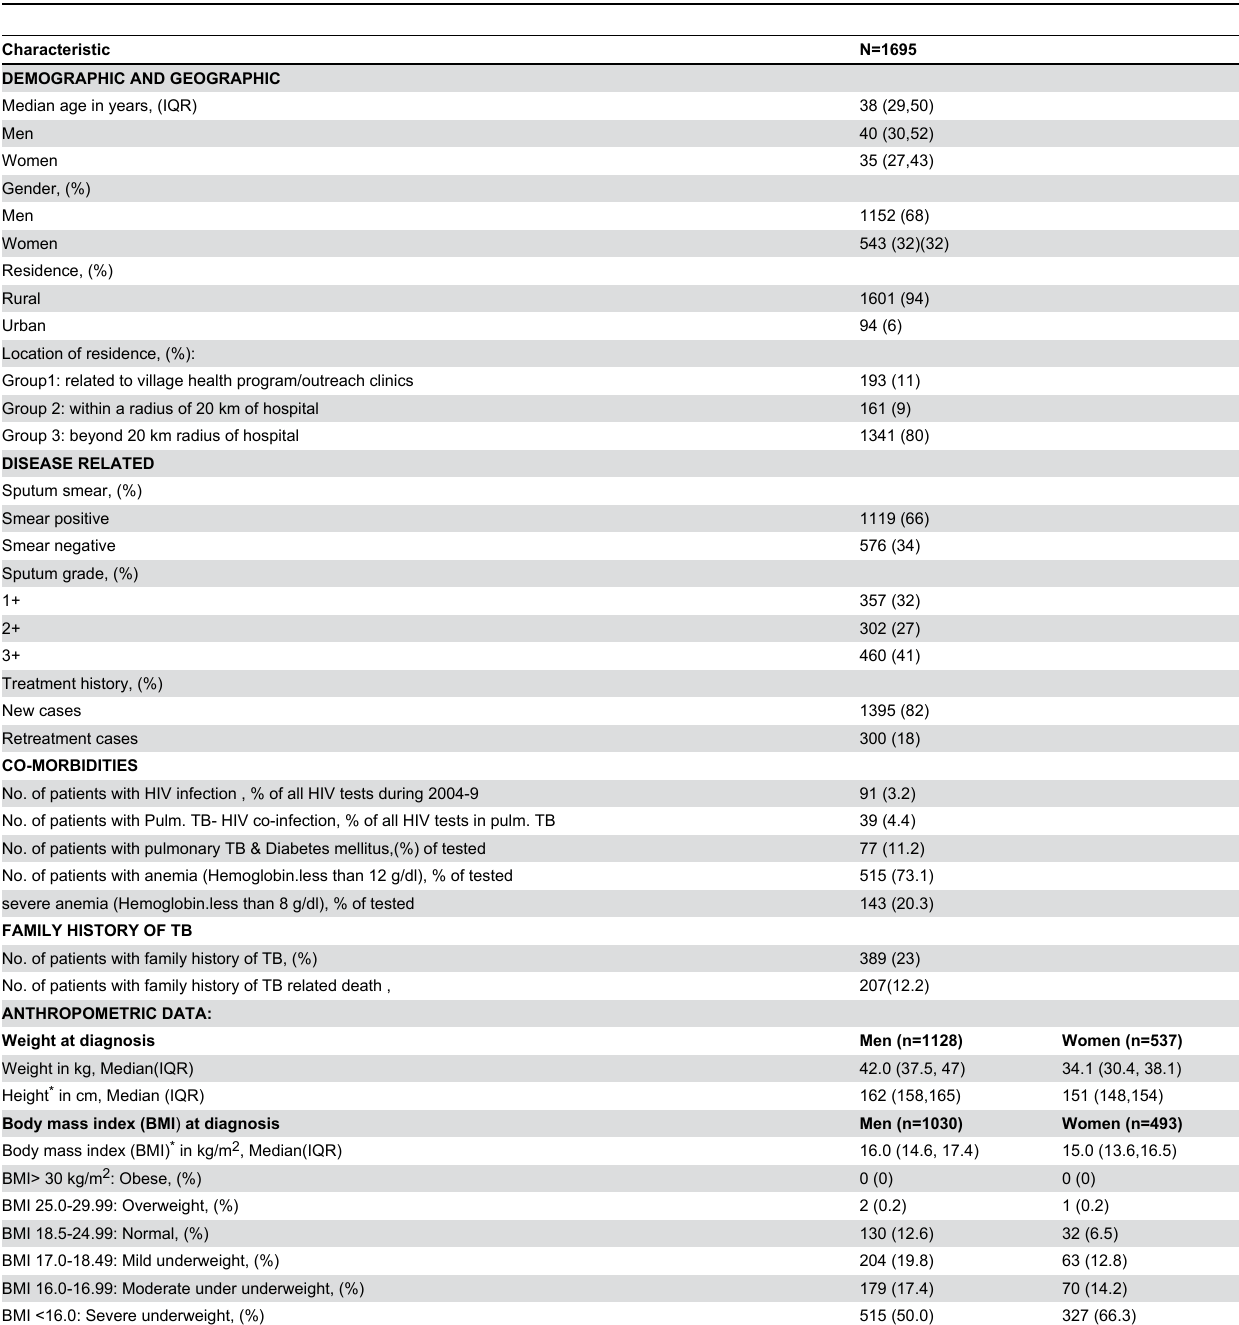
Table 1. Demographic, clinical, and anthropometric characteristics of all adult patients diagnosed with pulmonary tuberculosis at JSS